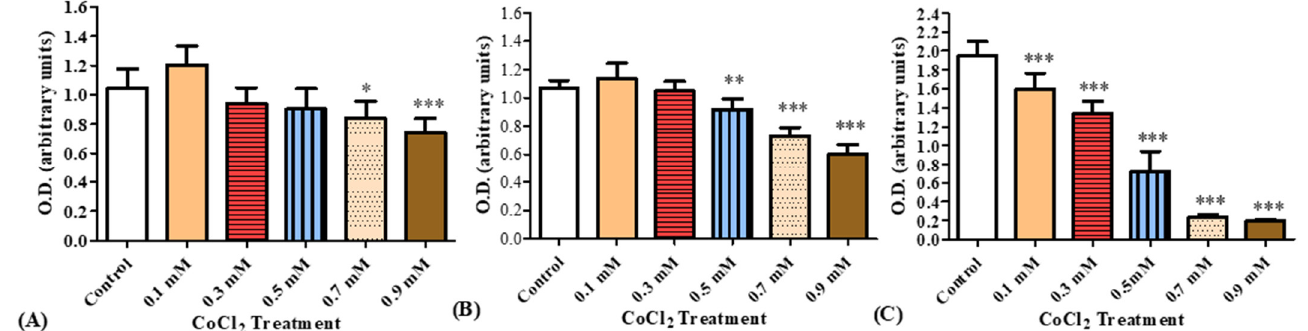
Figure 6. Cellular viability, as measured by XTT, of BV-2 cells exposed to increasing concentrations of CoCl 2 . XTT assay was performed after ( A ) 30 min, ( B ) 4 h, and ( C ) 24 h of CoCl 2 exposure at concentrations of 0.1, 0.3, 0.5, 0.7, and 0.9 mM. Results are expressed as mean ± SD ( n = 8 replicates for each group). * p < 0.05, ** p < 0.01, and *** p < 0.001 vs. control.